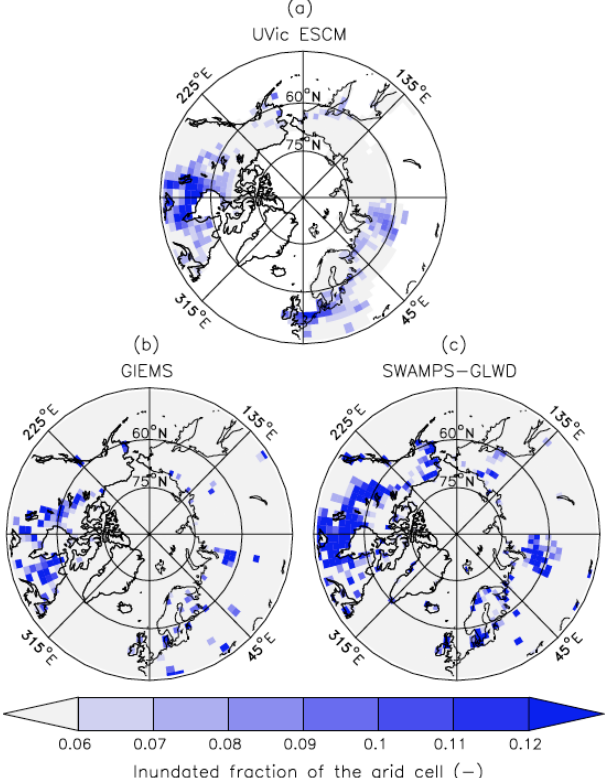
Figure 7. Average wetland extents (inundated fractions of grid cells) north of 45 ◦ N over the 2000–2007 period as simulated by the UVic ESCM (a) in comparison to two datasets: (b) GIEMS and (c) SWAMPS-GLWD. The datasets are regridded to 3.6 ◦ × 1.8 ◦ for a fair comparison with the UVic ESCM. The comparison period corresponds to the overlap period for the two